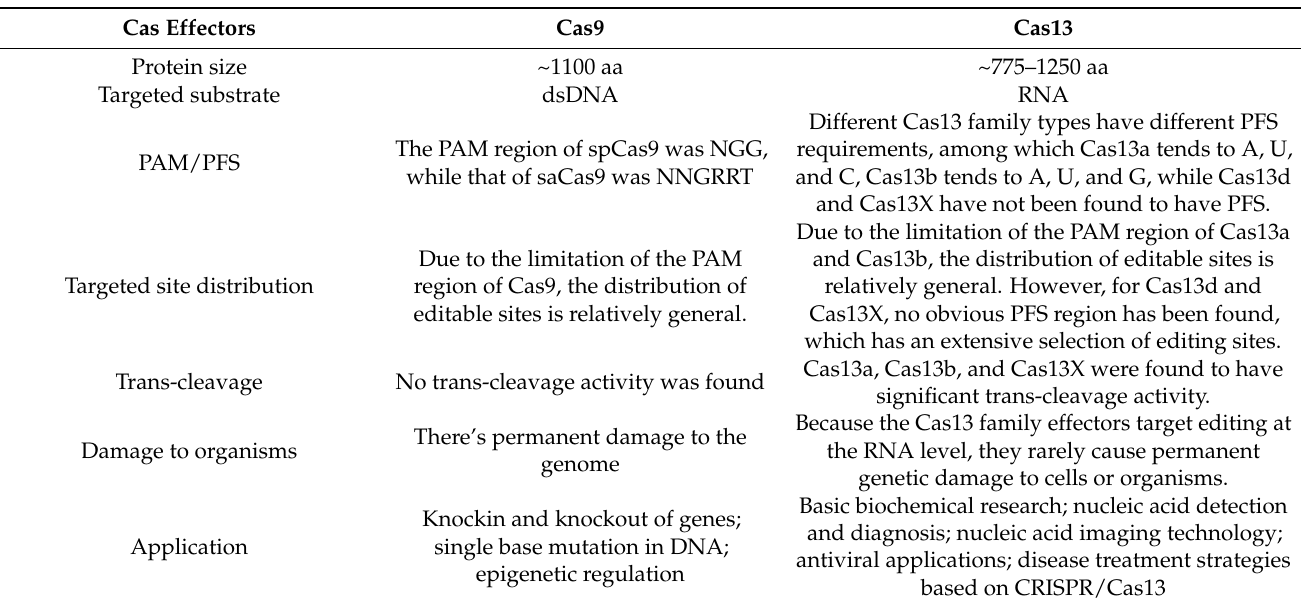
Table 1. Comparison of the Cas9 and Cas13